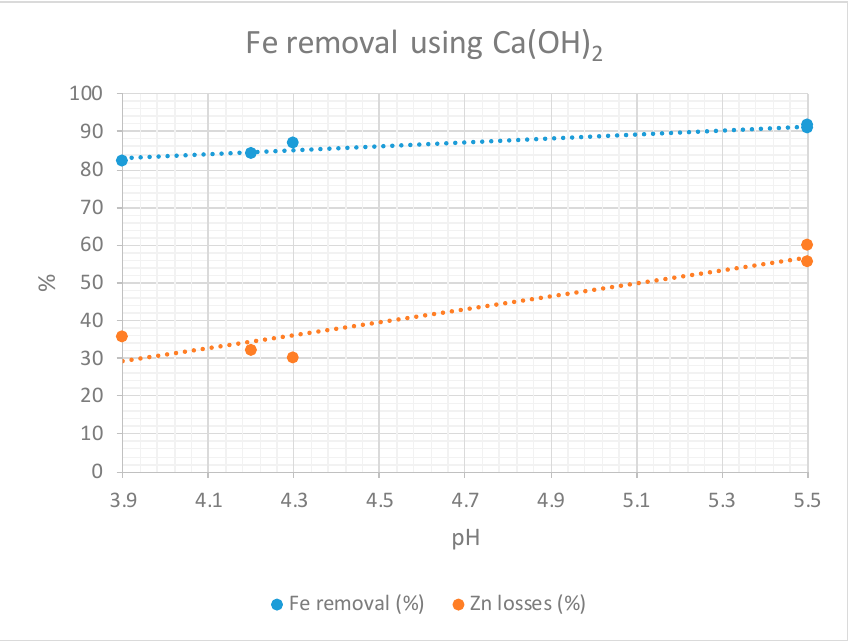
Figure 8. Exploratory test results using Ca(OH) 2 .